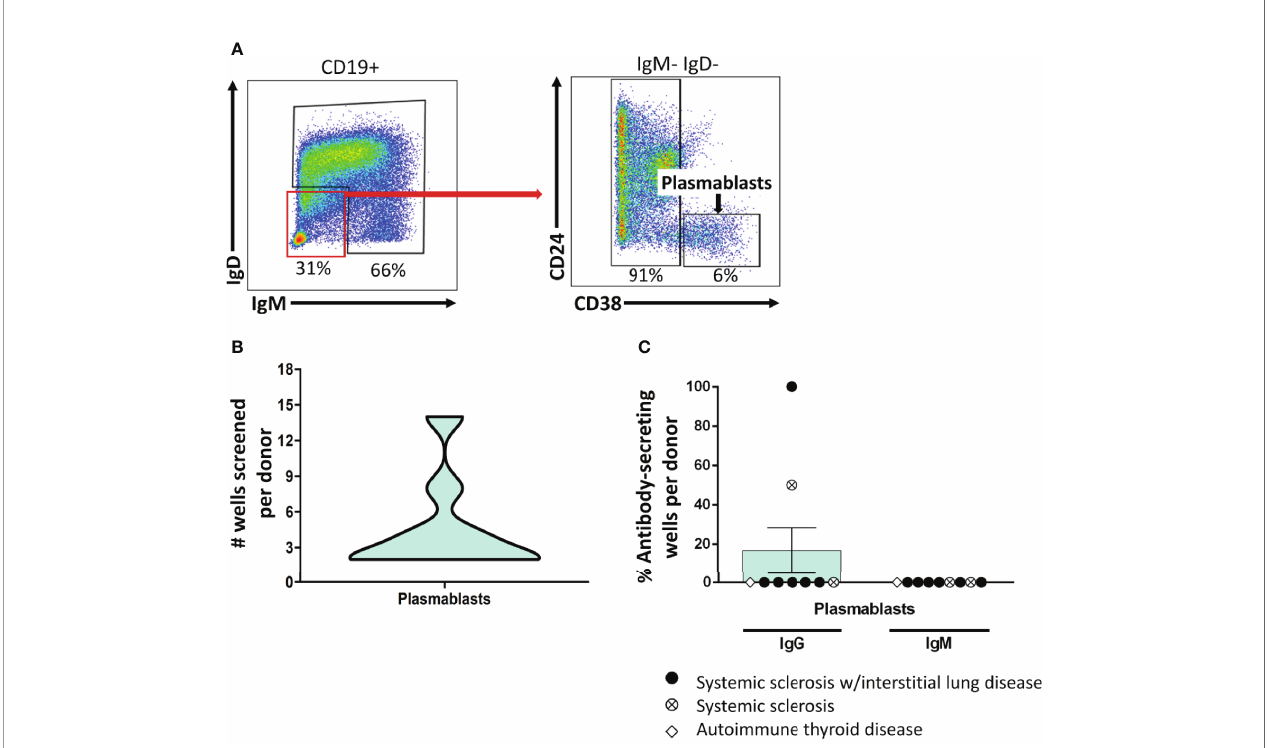
FIGURE 3 | Class-switched plasmablasts do not sustain antibody secretion following BCR/CD40/BAFF/TLR9/IL-21 stimulation. (A) PBMCs were isolated from autoimmune disease patients. Representative plots show fl ow cytometry identi fi cation of plasmablasts (CD19 + IgD - IgM - CD24 - CD38 - live singlets). (B) B cell subsets were identi fi ed as in (A) and fl ow cytometry puri fi ed. Plasmablasts were plated in 384-well plates at ~300 plasmablasts/well and stimulated as in Methods for 1 wk. The data distribution and density of the number of plasmablast wells that were screened per donor is expressed as a violin plot. (C) Culture supernatants from plasmablasts plated as in (B) were screened for antibody production by ELISA. Wells were scored positively for antibody secretion for ELISA OD 370nm > 0.5. The frequency of positive wells was calculated per subset, per donor; individual points represent individual donors. Results from systemic sclerosis/interstitial lung disease (black circle, n=6), systemic sclerosis (open circle/X, n=2), or ATD patients (open diamond, n=1) are